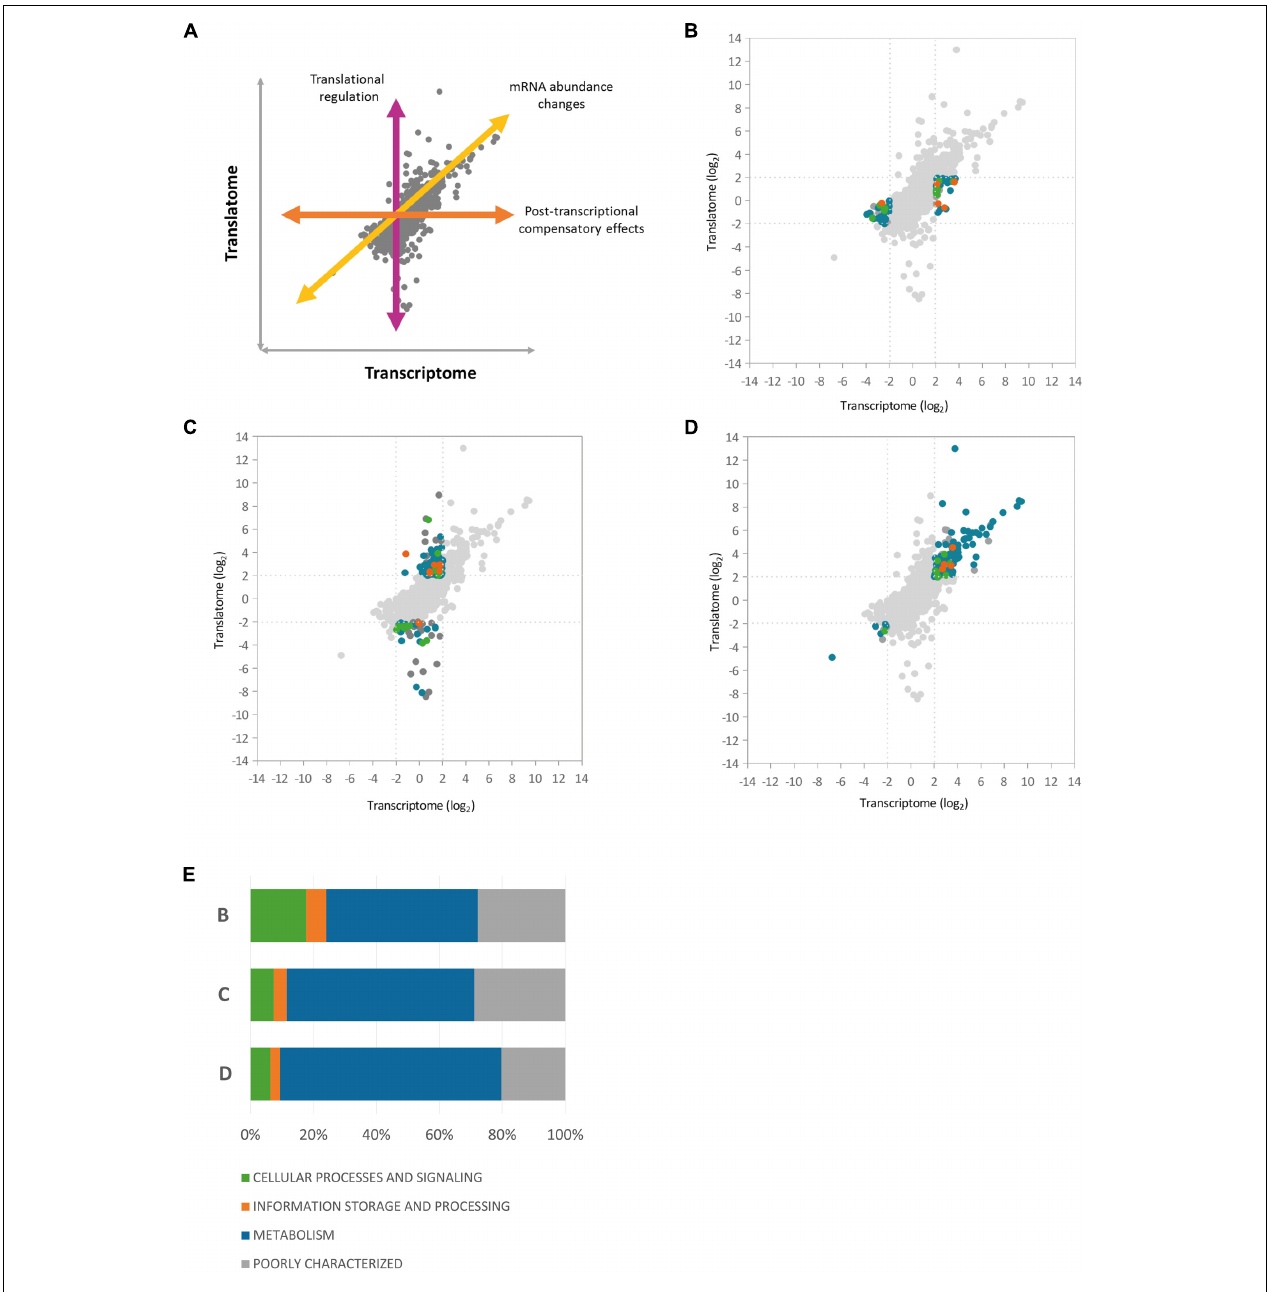
FIGURE 3 | Correlation between Hfq transcriptome and translatome. Scatter-plots representing the pairwise comparisons of log 2 ratios between Hfq transcriptome and translatome, highlighting three different regulatory classes of Hfq targets. (A) Illustration of the different regulatory effects on gene expression (B) Scatter-plot highlighting loci that showed altered mRNA levels in the hfq mutant but no corresponding change in translation (C) Genes showing significant translational perturbation without a comparable shift in the transcriptome. (D) Genes affected at both transcript abundance and translational levels. (E) The graph shows the relative abundance of each COG functional category at each of the regulatory levels shown in (B–D)